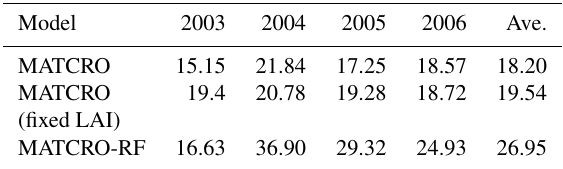
Table 6. RMSEs for daily LHF.